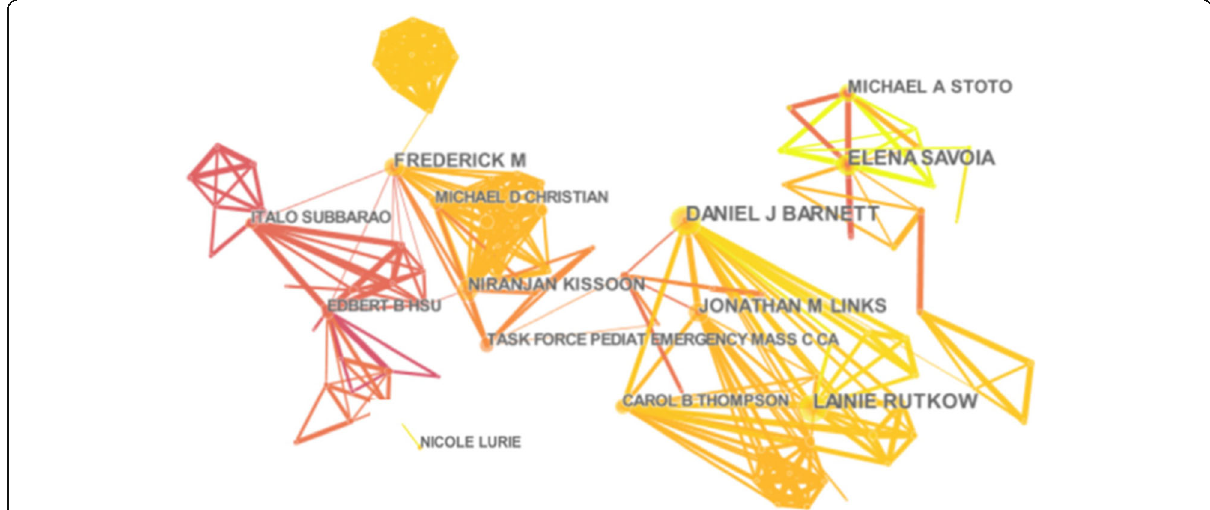
Fig. 3 Co-author network of international database. Different colors represent different time slices. The size of node represents the number of articles by the author. The link strength between two nodes means the collaboration intensity between